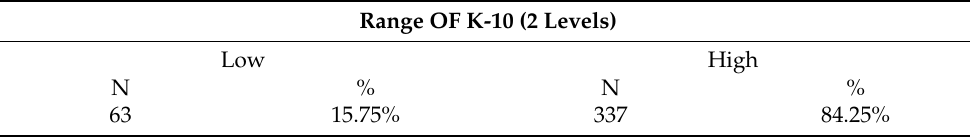
Table 2. Frequencies and percentages of the participants in the 2-level